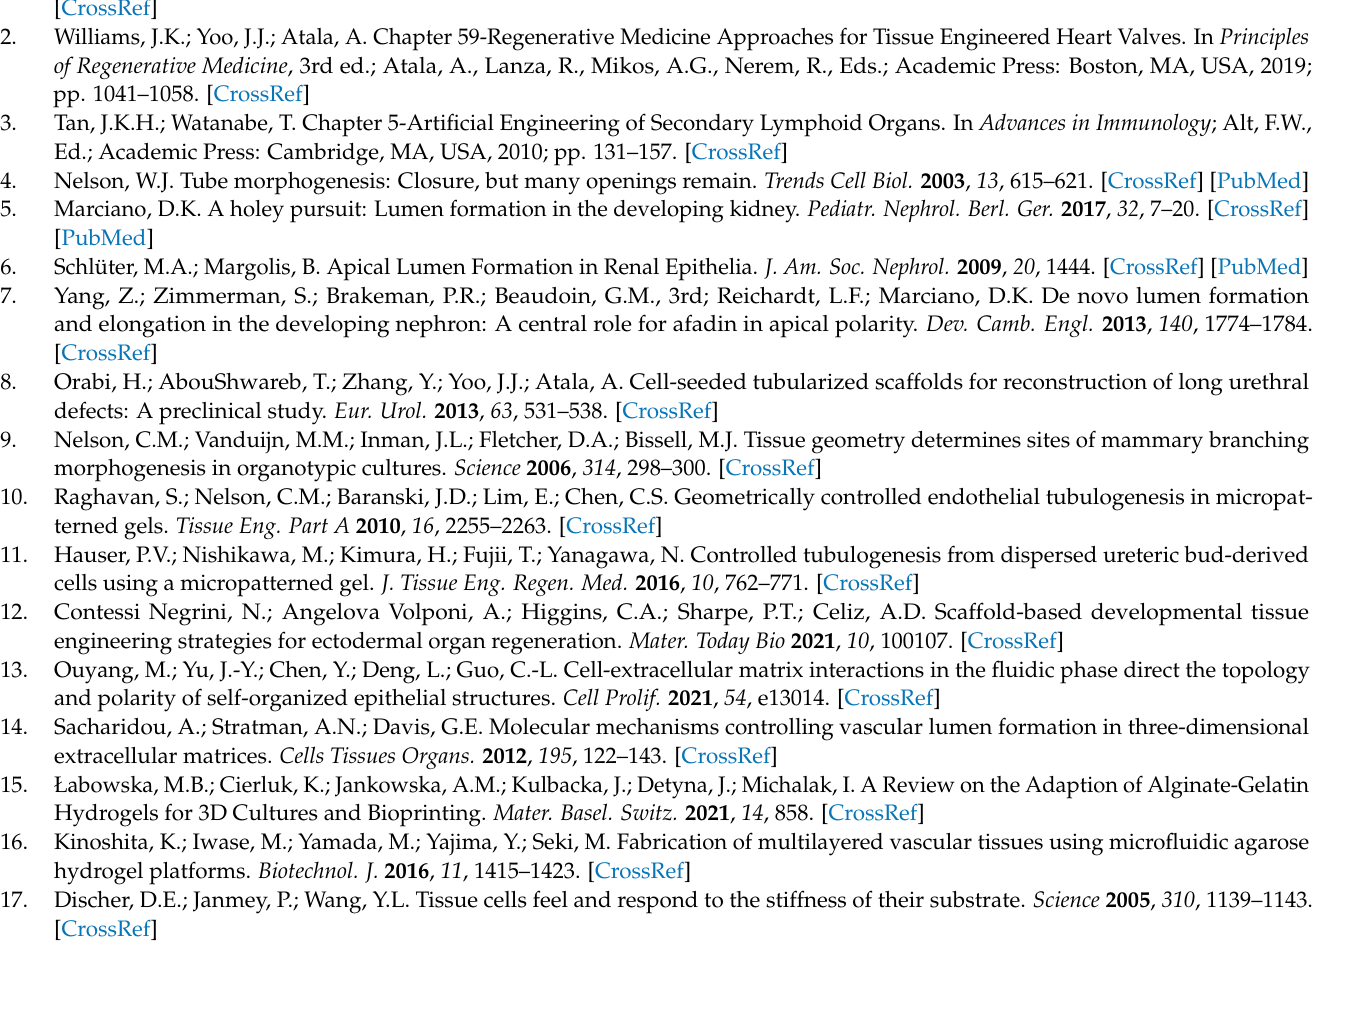
Figure S2: Force Displacement Plots for PDMS; Figure S3: Cell seeding based on PDMS mold orientation during